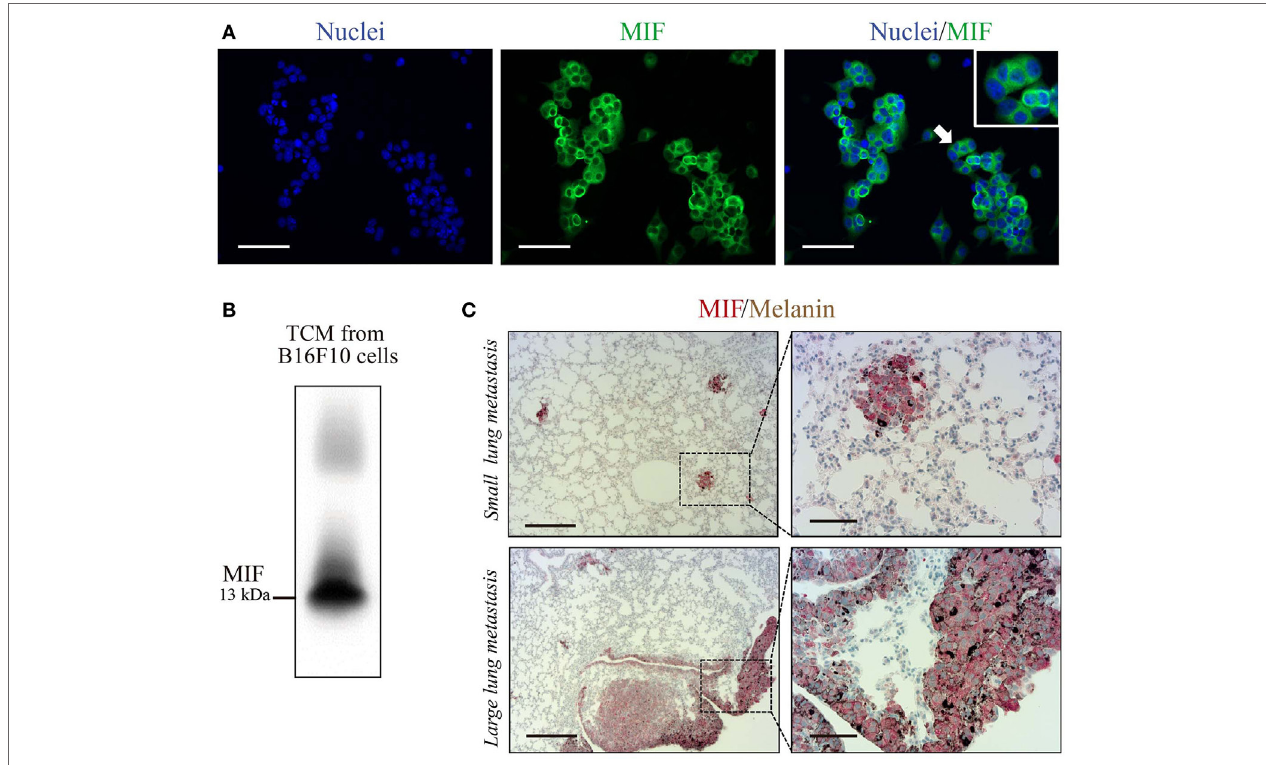
FigUre 3 | Macrophage migration inhibitory factor (MIF) is secreted by B16F10 metastatic melanoma cells and is highly expressed in lung metastatic lesions. (a) Immunofluorescent staining of B16F10 cells stained for MIF (green) and nuclei (blue). Scale bars: 50 µm. (B) Immunoblotting analysis of B16F10 tumor- conditioned media (TCMs) detecting secreted MIF. (c) Immunohistochemical staining of lung melanoma metastasis showing MIF (in red) in small and large lesions. Dark brown areas are metastatic foci of melanoma cells. Scale bars: 200 µm (left) and 50 µm